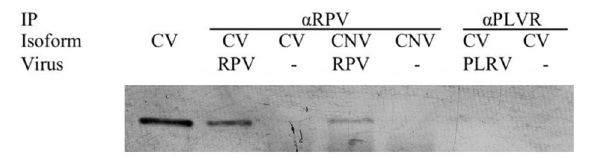
Figure 2. Interaction between the cyclophilin protein and CYDV-RPV and PLRV purified